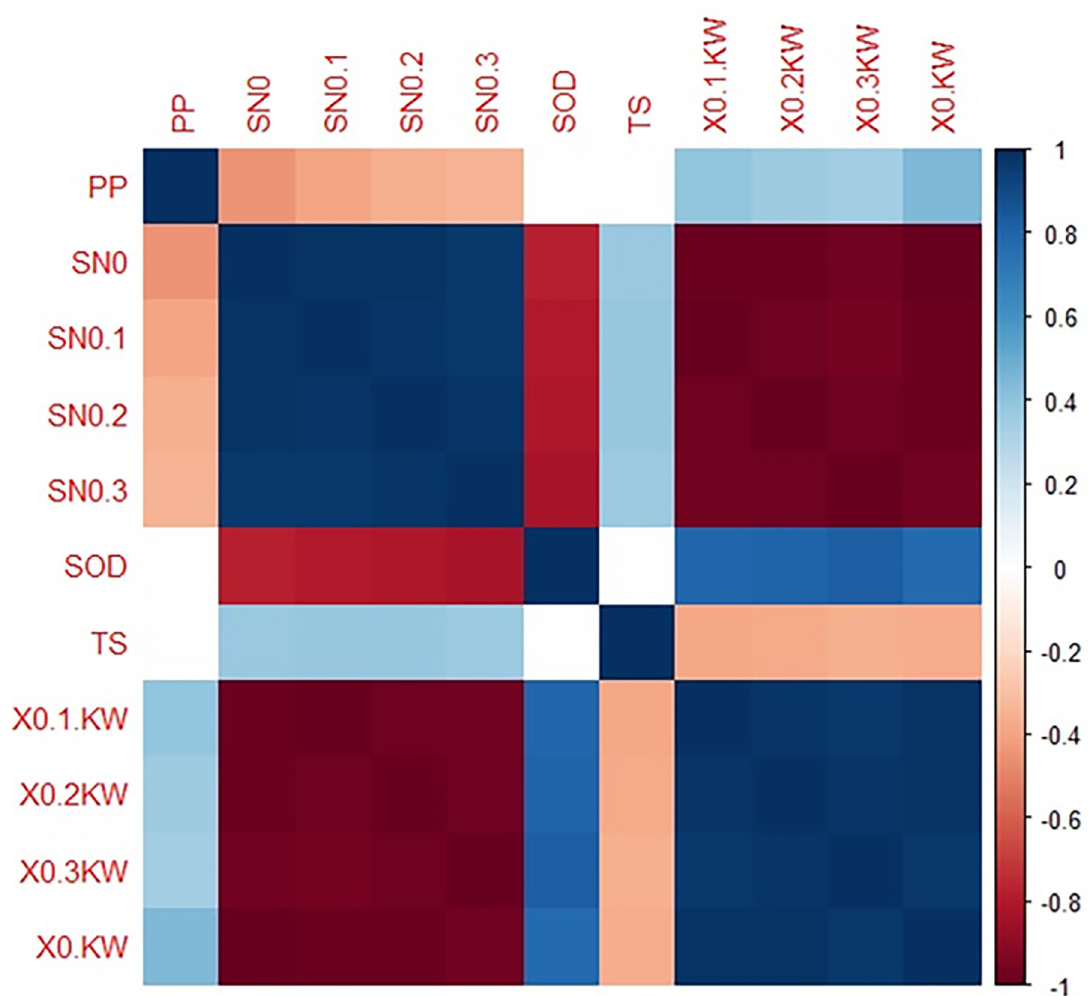
Fig 4. Hierarchical clustering of correlation coefficient matrix of input